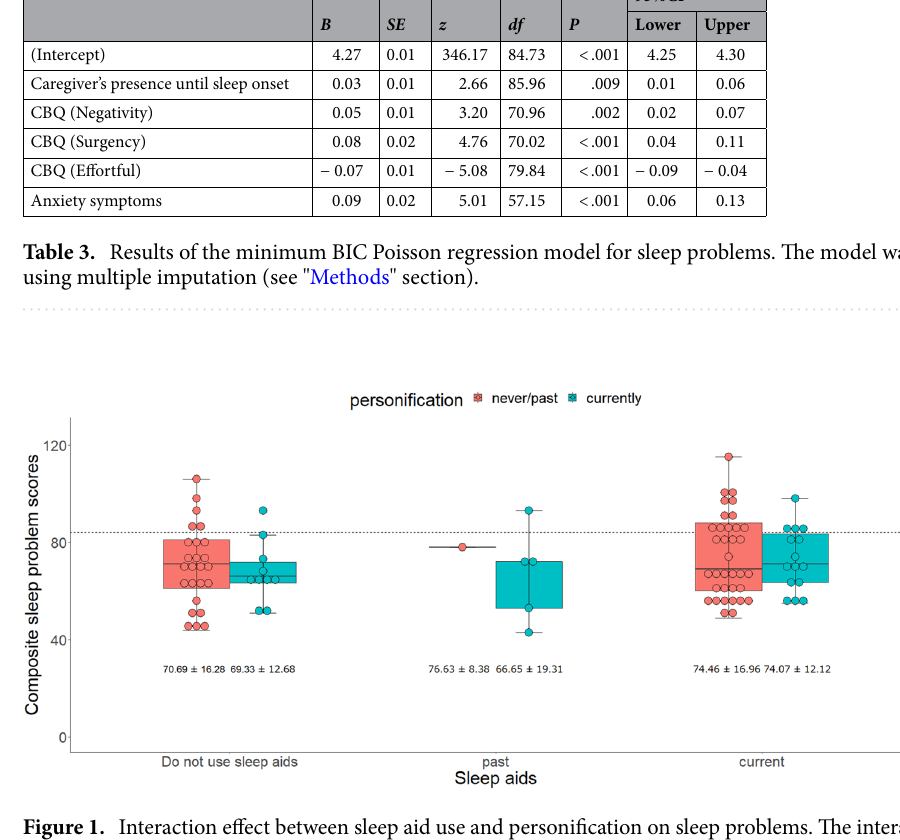
Figure 1. Interaction effect between sleep aid use and personification on sleep problems. The interaction effect term did not significantly predict sleep problem scores. The horizontal line indicates the cut-off value (84) of the Japanese sleep questionnaire for preschoolers. The numbers below the boxes indicate mean ± standard